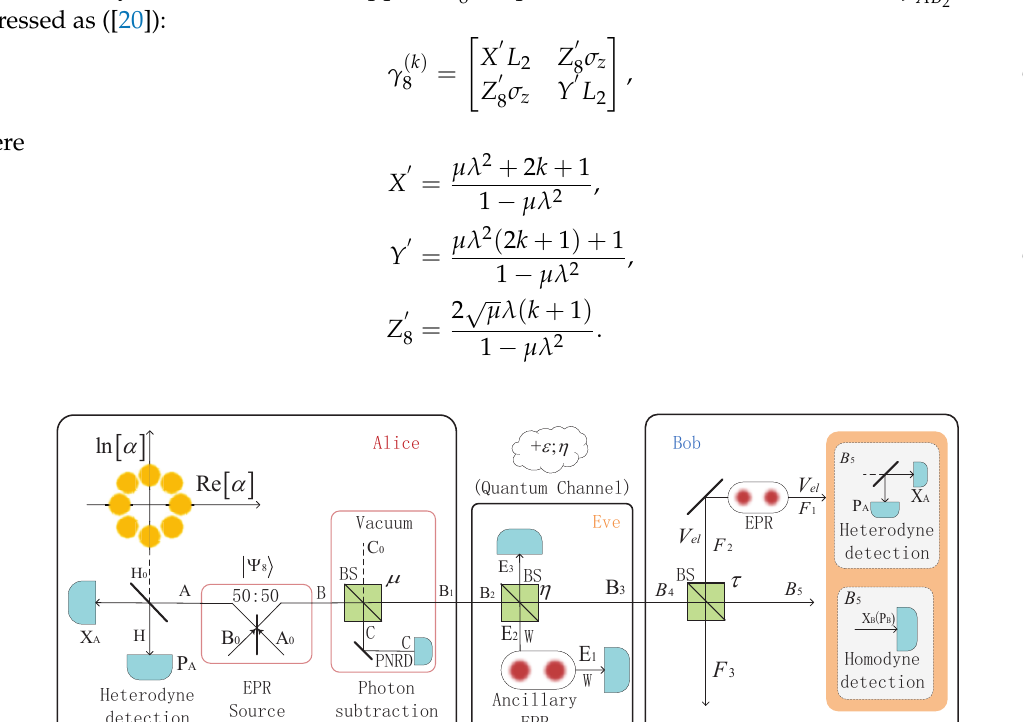
Figure 1. Prototype diagram of an improved eight-state discrete-modulated continuous variable quantum key distribution (CVQKD). Alice prepares one of the eight-state discrete modulation states. The rest of the state is passed through the photon subtraction module and then passed through the untrusted quantum channel to Bob. Bob will use homodyne or heterodyne detection to derive the key sequence shared by